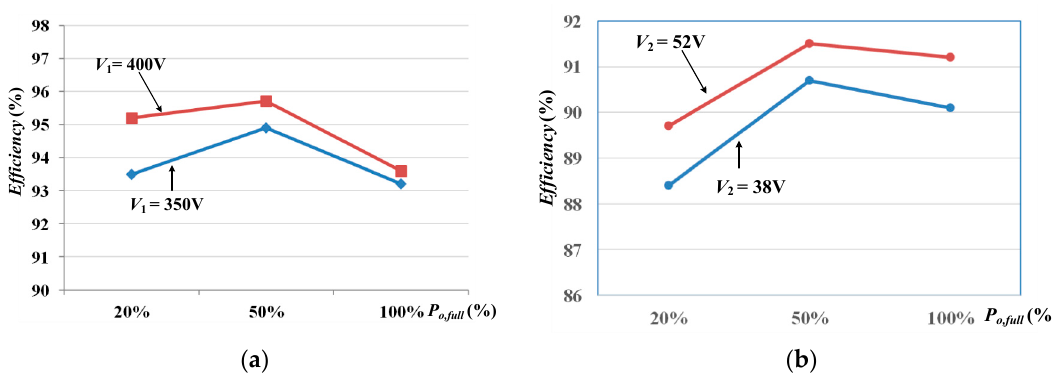
Figure 12. Measured circuit efficiencies of the studied converter under ( a ) forward power flow and ( b ) reverse power flow.